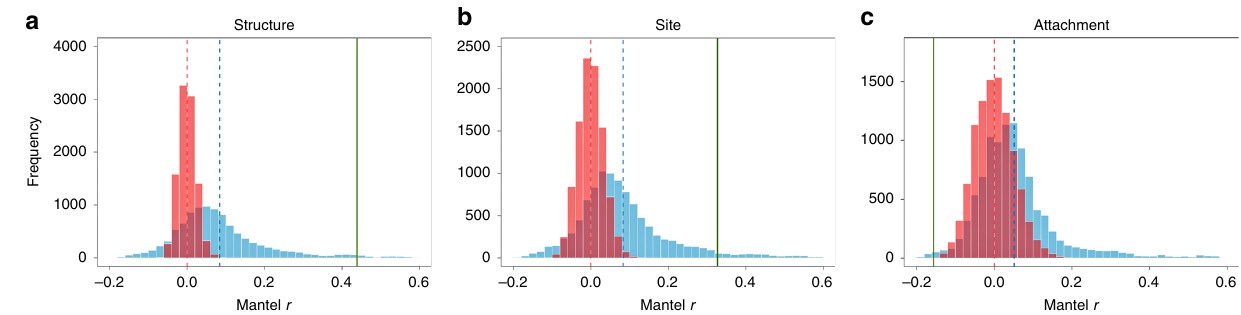
Fig. 3 Phylogenetic signal tests for nest characters. Mantel coef fi cients under the null hypotheses in conventional Mantel (red histograms) and EM-Mantel (blue histograms) tests. a Nest structure, b nest site, and c nest attachment. Red and blue dashed lines indicate the means of the expected values in conventional Mantel and EM-Mantel tests, respectively. Green lines indicate the empirical values for the three nest